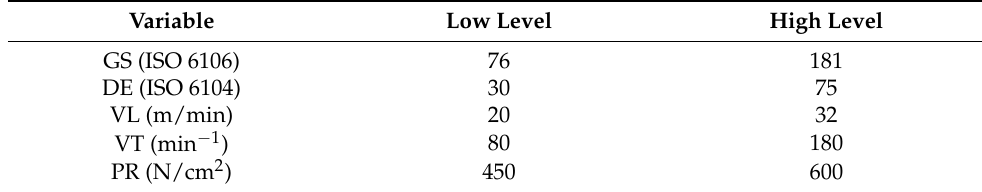
Table 1. Variables of the factorial design of experiments.